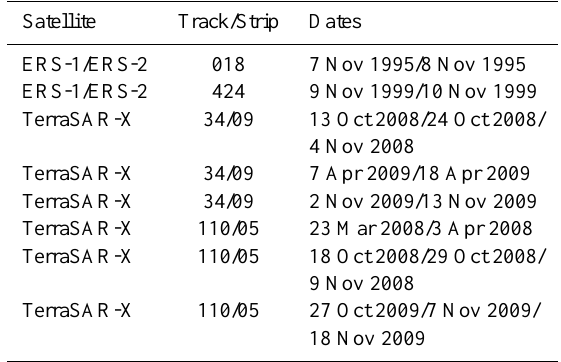
Table 1. Dates of satellite image pairs used for mapping glacier motion and estimation of mass fluxes.